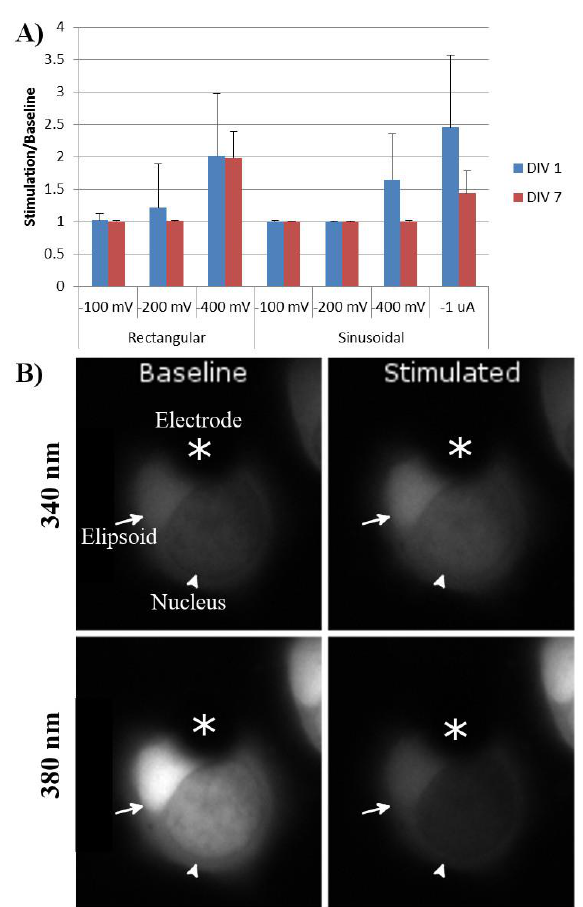
Figure 6. ( A ) Calcium response of tweezed rod photoreceptors to stimulation parameters of varying amplitude and type. Baseline was defined as the average intensity of 340 nm/380 nm for 50 s prior to stimulation. Response was defined as the average intensity of 340 nm/380 nm during stimulation. Rectangular stimulation was run with negative stimulation at the indicated amplitude for 100 µs, followed by no stimulation for 60 µs, followed by positive stimulation at the indicated amplitude for 100 µs. Sinusoidal stimulations were run at 5 Hz at the indicated amplitudes. n = 20 cells, four animals. Error bars = standard deviation. ( B ) Example of a rod photoreceptor one DIV prior to and during stimulation by the MEA electrode. Dark area covering a portion of the cell was the MEA electrode (asterisks). Bright area was the rod ellipsoid (arrow), while the other darker region was the nucleus of the rod photoreceptor (arrowhead). After seven DIV, the same rod photoreceptors were again stimulated, using the same parameters. Cells had remained on the electrodes during this time, and no significant cell death was seen. Rod-cell responses to rectangular stimulation were similar to those at day one; however, their responses to -400 mV and -1 µA sinusoidal stimulation had significantly decreased (Figure 6). 4. Discussion The protocol that we have described, utilizing optical tweezers in conjunction with an MEA, allows a user to specifically maneuver individual neurons onto selected electrodes. The substrate used here to make the MEA non-adhesive (p-HEMA) so that cells can be picked up by the laser should have general applicability. However, the adhesive substrate used for cell growth is specific for adult salamander neurons and, thus, should be selected depending on the cell system used. Other cell-placement techniques, such as cell printing [20,21], have been suggested. Nakamura et al., in 2005, demonstrated that they could “print” dots of cells with an accuracy of 8.8 to 17.6 μm. However, each dot varied in the number of cells it contained and was 80 to 260 µm in diameter, making